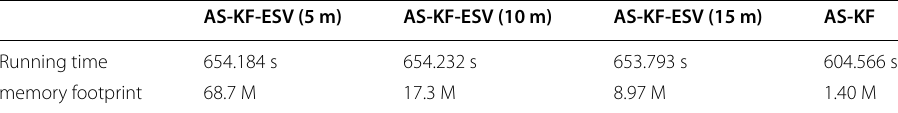
Table 1 Analysis results of algorithm